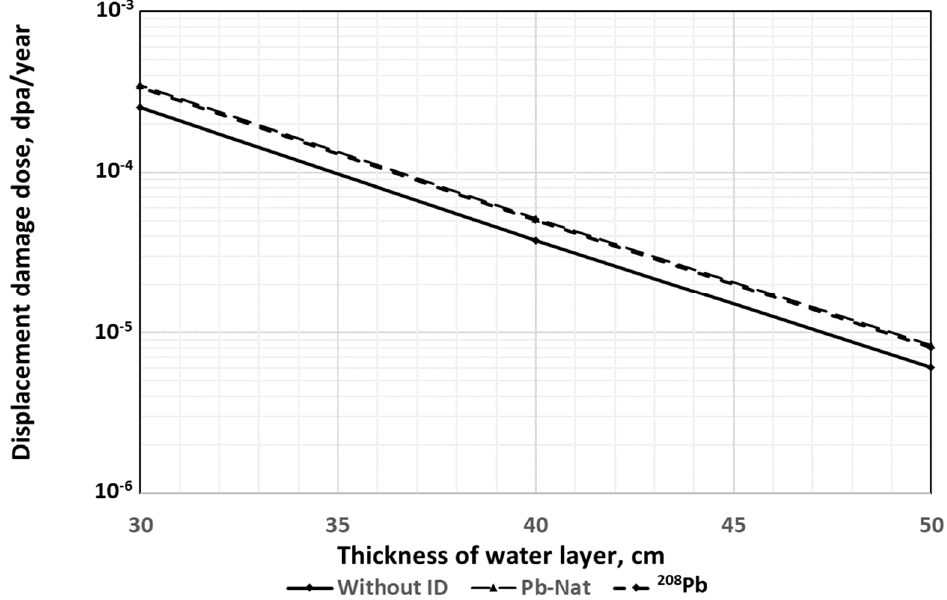
Figure 11. Displacement damage dose for the reactor vessel under different water gap thicknesses.